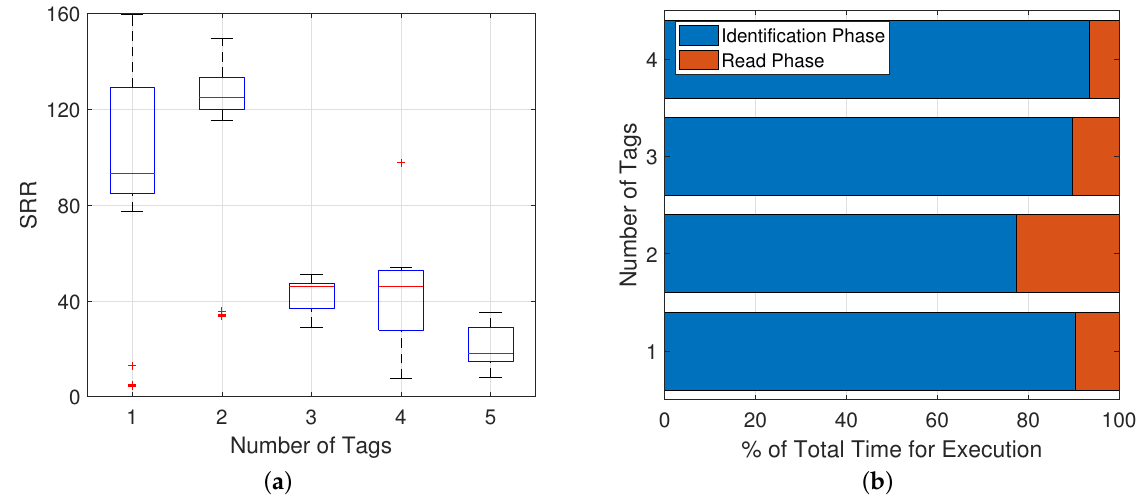
Figure 12. sFSA results on SRR with N = 1, 2, 3, 4 and S = 5. ( a ) Boxplot of sFSA with N = 1, 2, 3, 4, 5 and S = 5. ( b ) Percentage of Identification and Sense Phase of the total time execution with N = 1, 2, 3, 4, 5 and S =